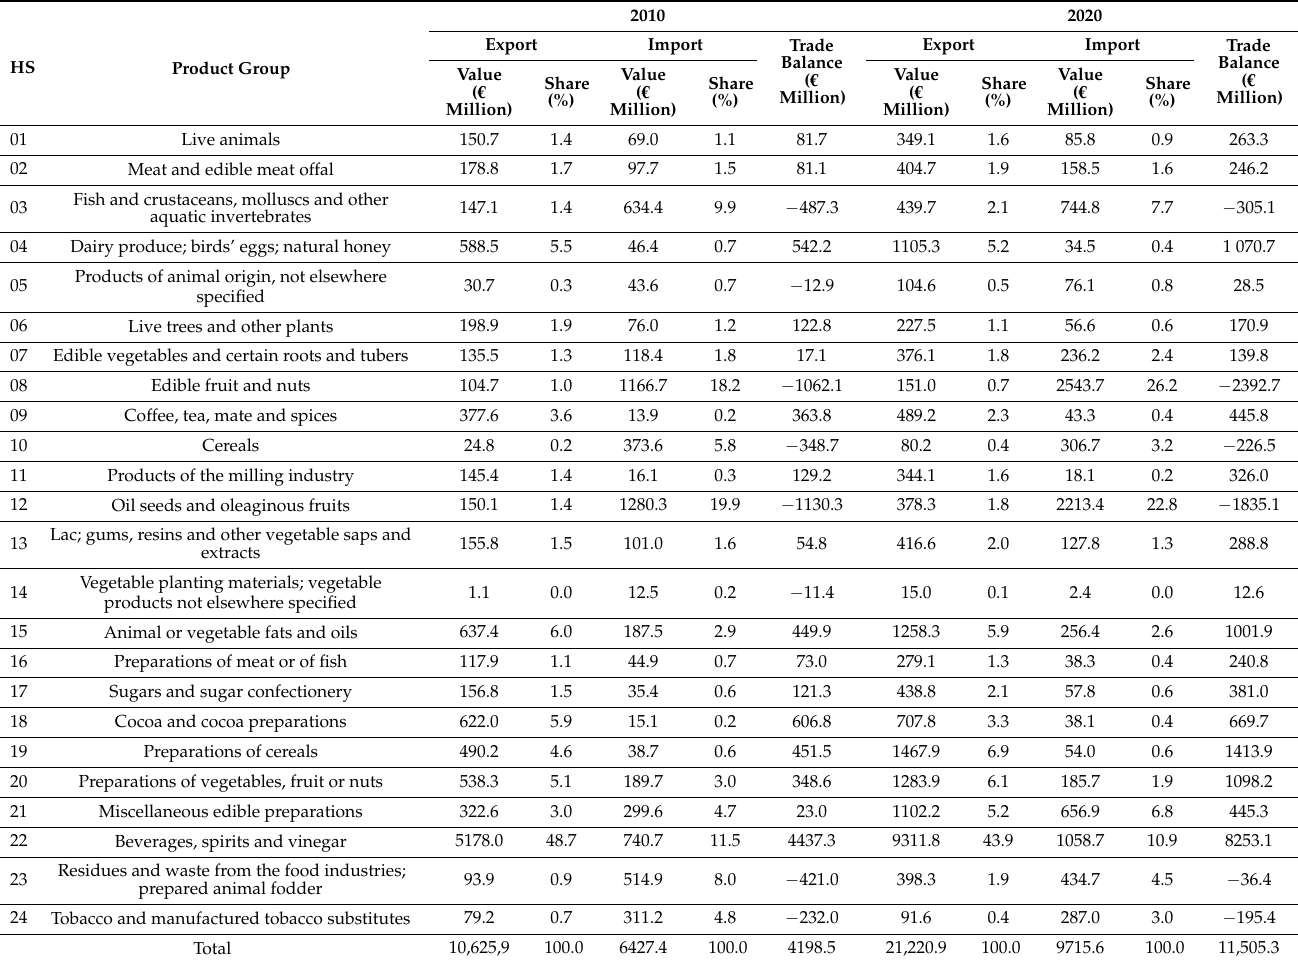
Table 4. Commodity structure of agri-food trade between the EU and the US in 2010 and 2020 by the Harmonized System (HS)